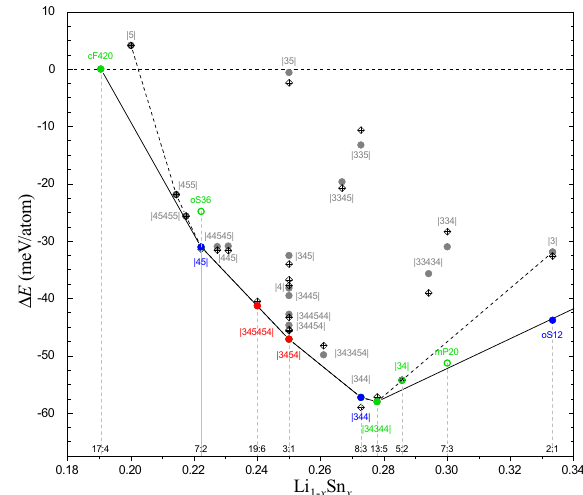
Fig. 7 Stability of Li-rich phases relative to cF420-Li 17 Sn 4 and mP6-LiSn. In addition to the evaluation with the DFT (solid circles), the stability of phases with the [111] BCC morphology, denoted with block sequences explained in the text, is also approximated with a phenomenological model (crossed diamonds). The DFT convex hulls shown with dashed and solid lines correspond to the [111] BCC subset and all considered phases, respectively. The Li-Sn phases observed experimentally, proposed previously, and predicted in this study are shown in green, blue, and red, respectively.